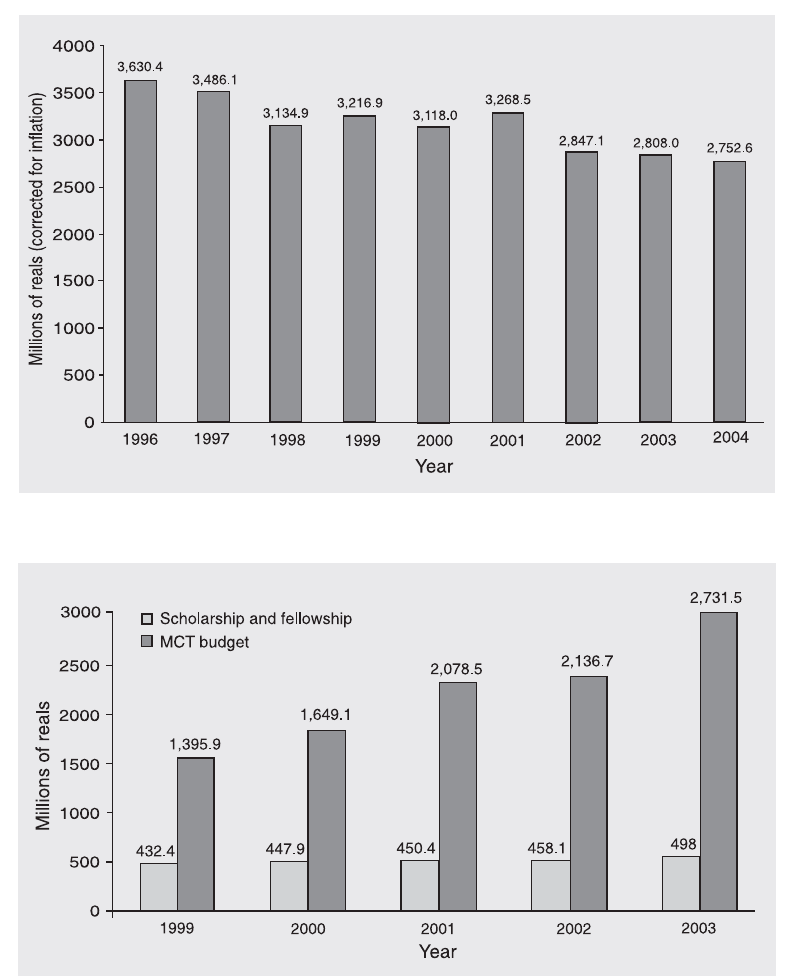
Figure 3. Federal investment in scientific research and development in Brazil between 1996 and 2004, cor- rected for inflation using the IGP-DI, and considering 2002 as the reference point (original data source: Min- istry of Science and Technology, http://www.mct.gov.br/ estat).